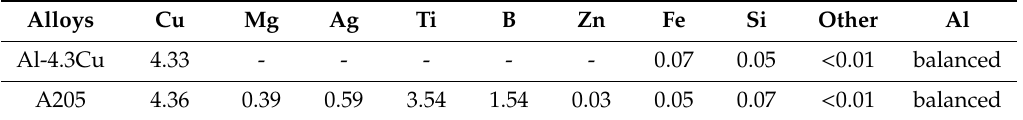
Table 1. The detailed composition of alloys in wt. %.